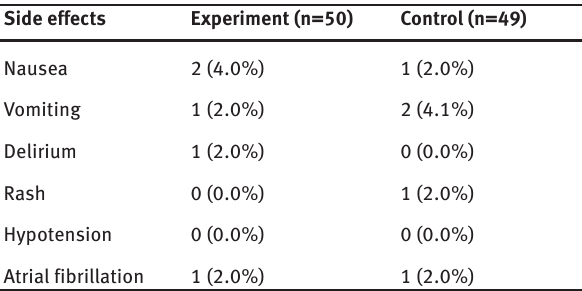
Table 4: The risk of side effects in the two groups of patients [N, (%)]. Side